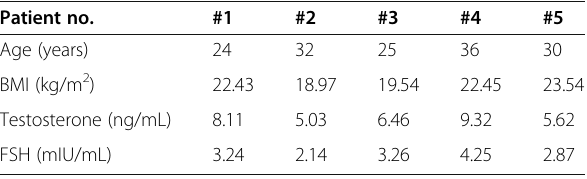
Human testis samples were obtained by testicular puncture from men with obstructive azoospermia whose samples exhibited histologically normal spermatogenesis